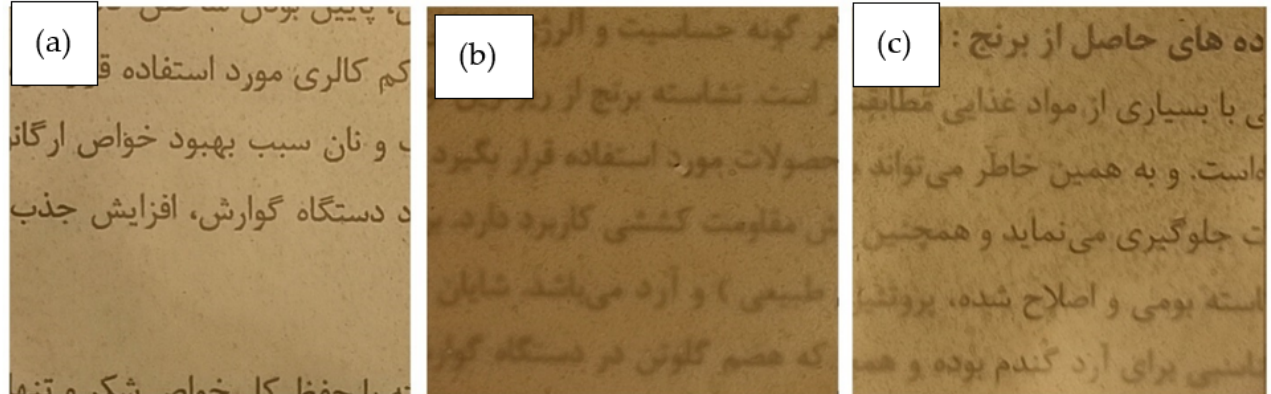
Figure 9. Appearance of ( a ) control modified BSG edible film and those incorporated with tannic acid and vitamin D 3 in ( b ) encapsulated form in nanophytosome and ( c ) free form. According to Table 3, the film thickness did not significantly change in the presence of free and encapsulated forms of tannic acid and vitamin D 3 , although the film thickness was